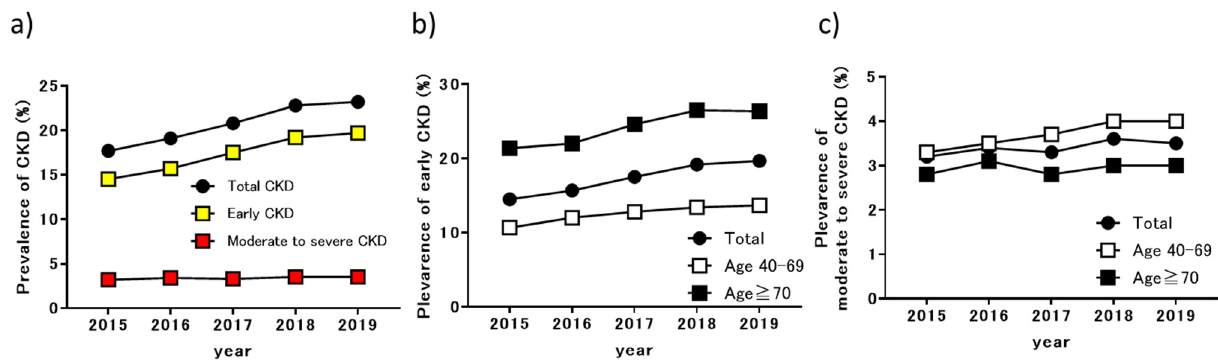
Figure 2. Changes in the prevalence of CKD among examinees undergoing NHI health checkups: ( a ) changes in CKD prevalence each year; ( b ) changes in the prevalence of early CKD stratified by age; ( c ) changes in the prevalence of moderate-to-severe CKD stratified by age. CKD, chronic kidney disease; NHI, national health